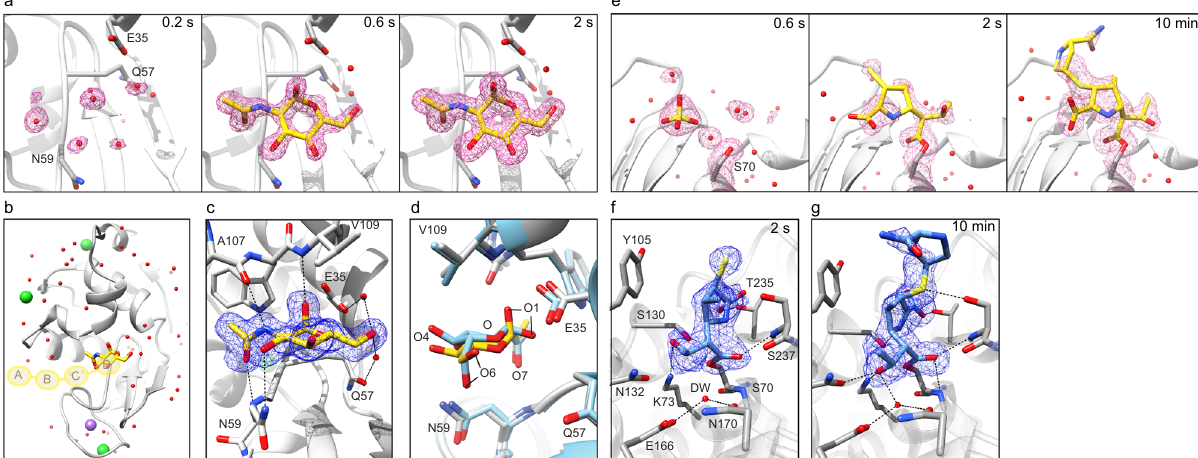
Fig. 2 Drop-on-drop delivery enables the analysis of N-acetyl-D-glucosamine (GlcNAc) binding to the HEWL active site and catalytic activity of CTX- M-15 by serial X-ray crystallography. a 2mF o – DF c electron density maps for HEWL-GlcNAc XFEL structures, displayed at ±1 σ contour level and carved at 2 Å around the GlcNAc ligand. The GlcNAc molecule from the 2 s time point structure was used to carve the 200 ms time point map. All maps are at 1.45 Å resolution. b Cartoon representation of the HEWL structure (2 s mixing time point, PDB ID 7BHN). GlcNAc is shown as sticks and colored in yellow. Waters, sodium, and chloride ions are shown as red, purple, and green spheres, respectively. Ligand binding subsites A-D (as in PDB ID 5NJR 10 ) are indicated by yellow circles. c , d Close-up active site view of the HEWL structure shown in ( b ). c mF o – DF c polder OMIT difference density map contoured at ±3 σ and carved 1.5 Å around the ligand site. Hydrogen bonding network is highlighted. d Superimposition of the 2 s mixing time point structure (yellow and gray) and the single-crystal room-temperature structure of HEWL soaked with GlcNAc obtained by Tanley et al. 25 (light blue, PDB 3TXJ). e 2mF o – DF c electron density maps of CTX-M-15 structure displayed at ±1 σ and carved at 2 Å around the ertapenem ligand (pink; 1.55, 1.55, and 1.65 Å for 0.6 s, 2, and 10 min, respectively). The 0.6 and 2 s time points are calculated with XFEL data, whereas the 10 min time point is calculated with room temperature, SSX data collected at Diamond Light Source. f , g Close-up view at the active site of the structure obtained after 2 s ( f ) and 10 min ( g ) of mixing with ertapenem. Interactions of ertapenem (blue sticks) with residues on the protein main chain (gray sticks) as well as the interactions of the proposed deacylating water (DW, red sphere) with the protein are shown as black dashes. mF o – DF c polder OMIT difference density maps are contoured at ±3 σ and carved 1.5 Å around the ligand site. Ertapenem has been tentatively modeled and re fi ned into the observed electron density as the ( R )- Δ 1 -pyrroline tautomer for both 0.6 s and 10 min structures (see Supplementary Note 3). Graphic was created using the UCSF Chimera package 54